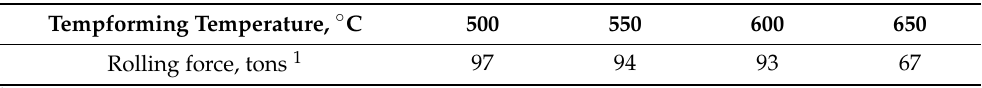
Table 3. Effect of tempforming temperatures on rolling force in tons at a rolling reduction of ~8% for one